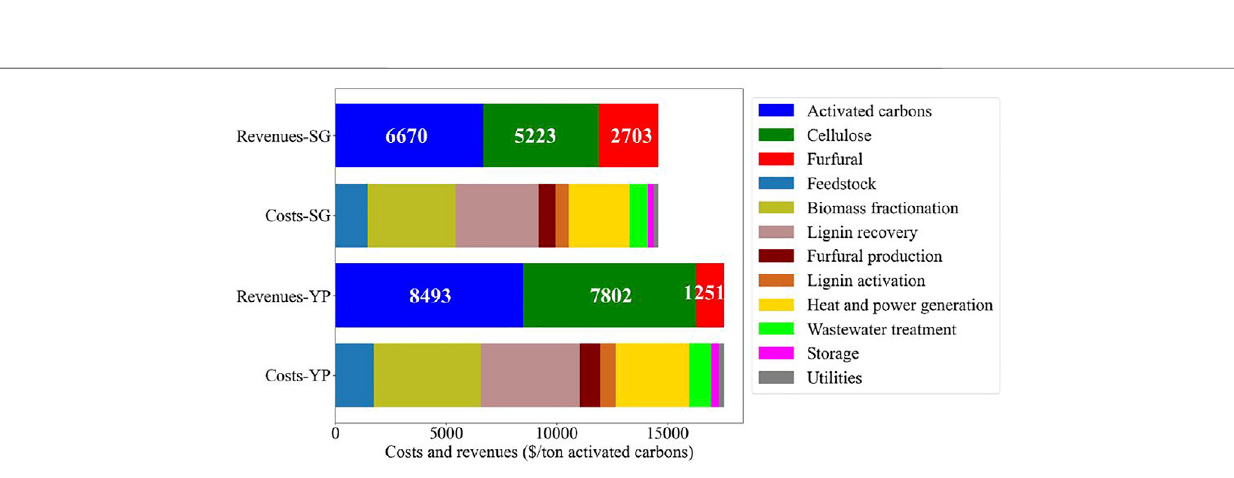
FIGURE 11 | Cost breakdown by process area for SG and YP-based biore fi